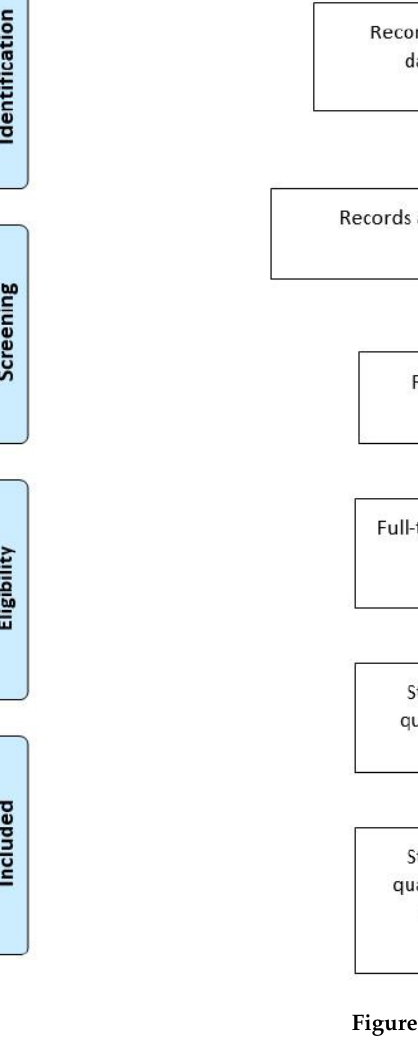
Figure 1. Prisma flow chart.